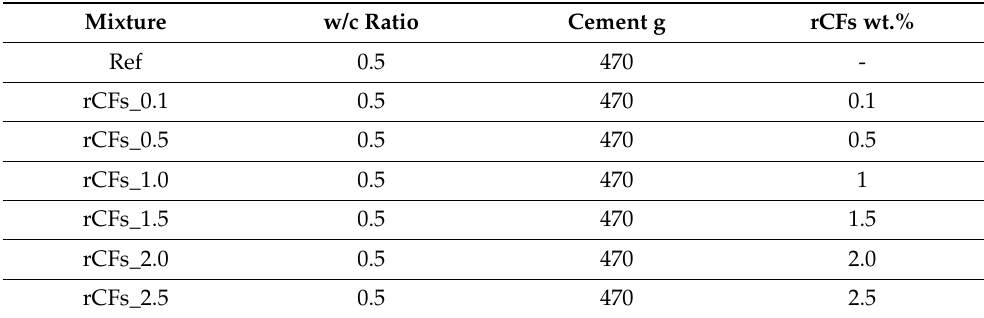
Table 4. Mix proportions for reference and rCFs-composites.